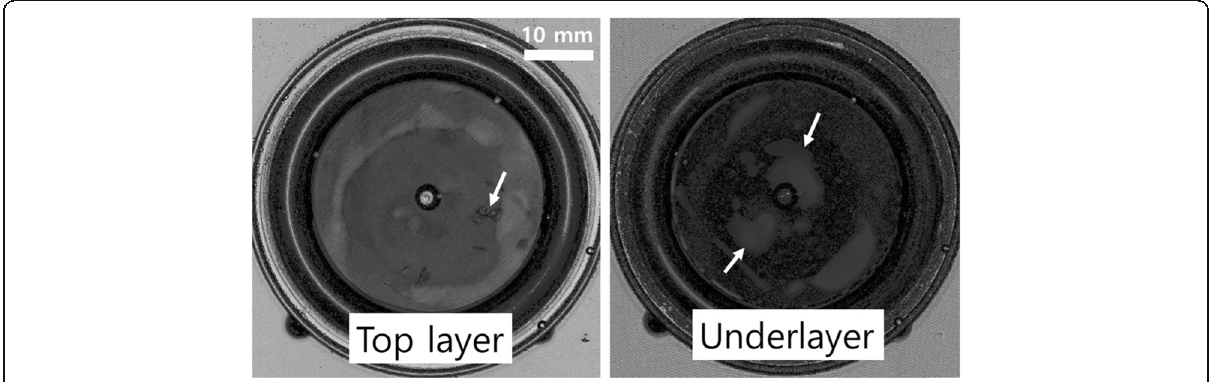
Fig. 6 Image of the EPDM flange obtained from its C-scan (50 MHz transducer, lateral resolution ~ 30 μ m, 512 px × 512